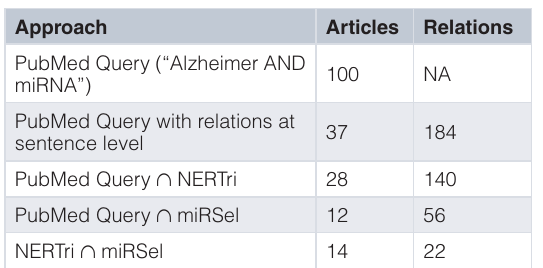
Table 8. miRSel database comparison. Comparison of miRNA-gene relations retrieval for Alzheimer’s disease in